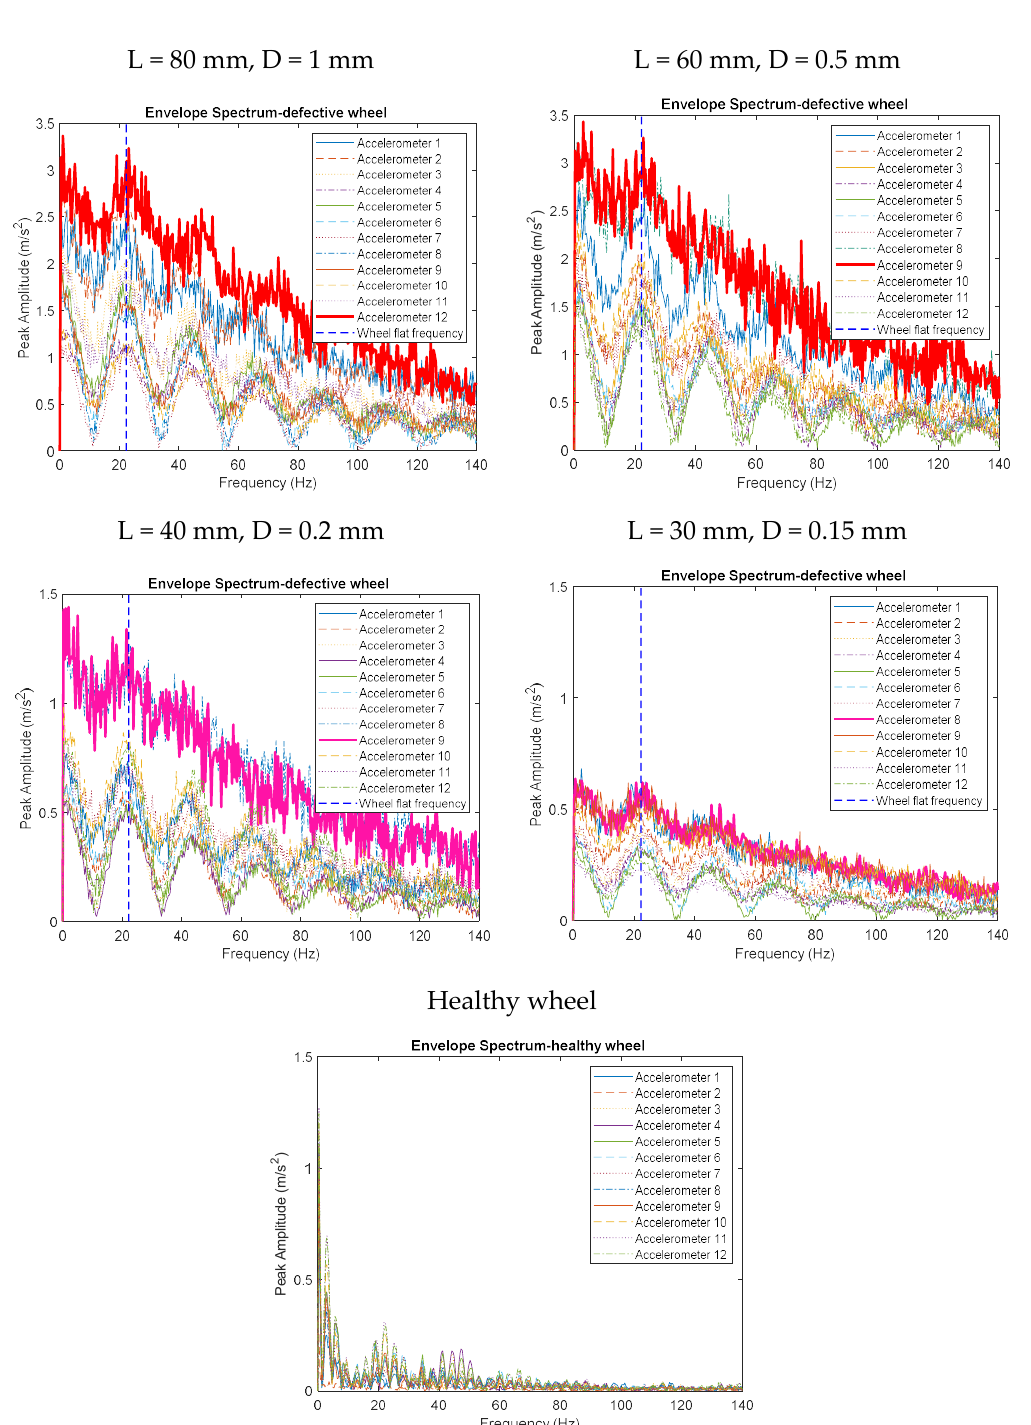
Figure 17. Envelope spectrum analysis for 12 accelerometers (layout scheme 2) considering a defective and a healthy wheel of the Alfa Pendular due to the severity of the flat considering 10% noise.